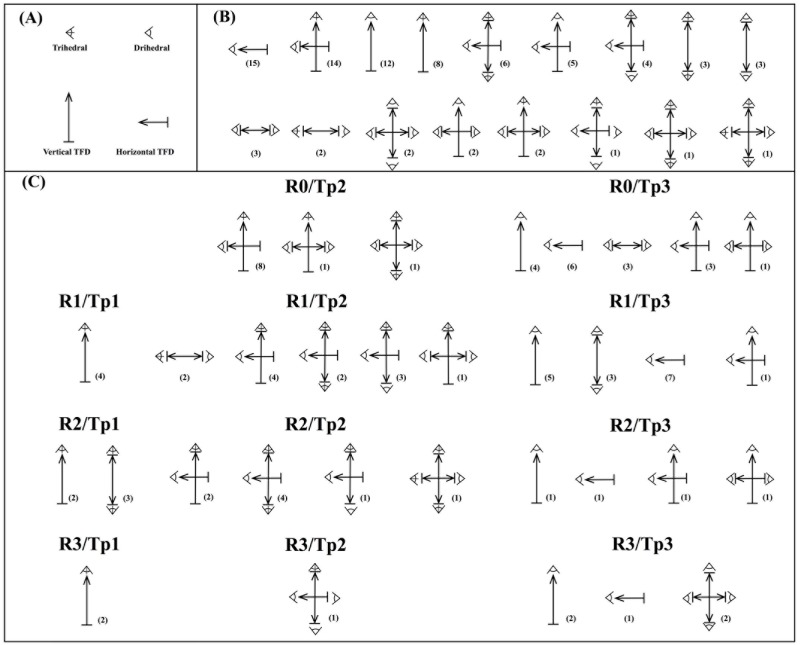
Tool functioning schemes.(A) Legend (Tool functioning direction = TFD). (B) Tool functioning schemes according to their numerical representation. (C) Tool functioning schemes sorted by reduction intensity (RI) and type of artifacts (Tp).